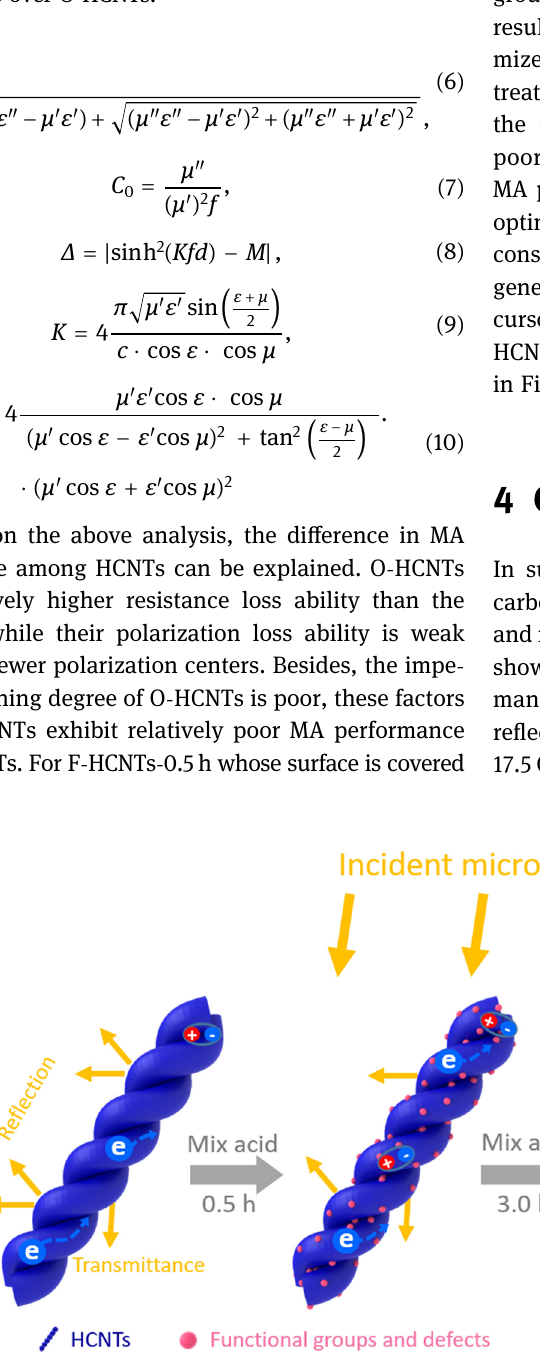
Figure 6: Schematic illustration of the potential MA mechanisms for